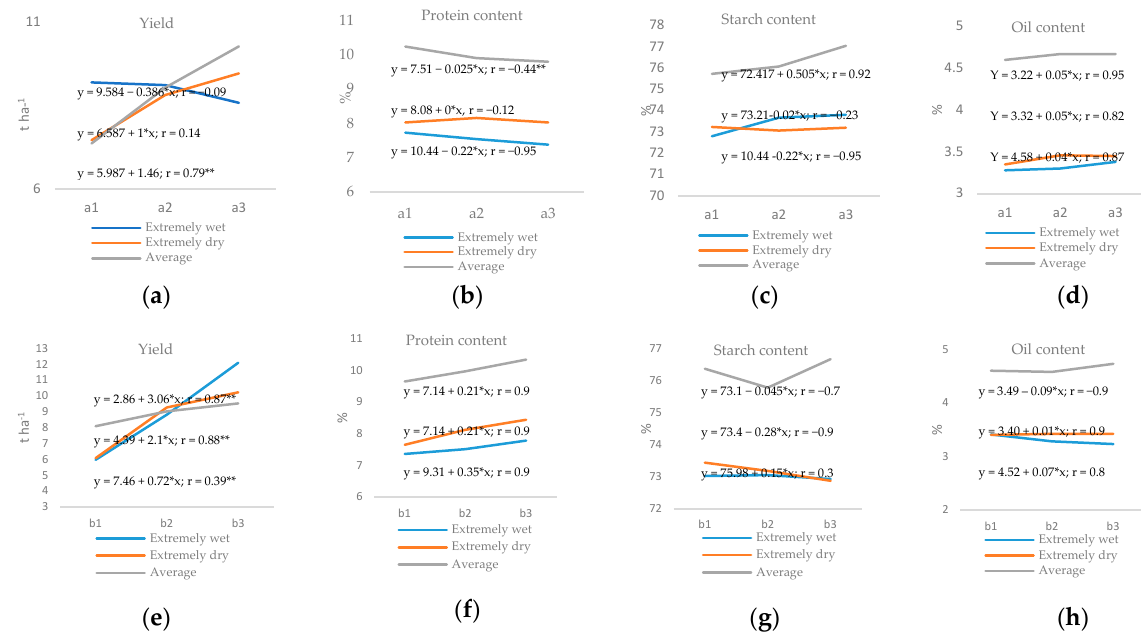
Figure 7. Relationship between irrigation (a1 = rainfed, a2 = 60–100% field capacity (FC), and a3 = 80–100% FC) and the tested variables—( a ) yield, ( b ) protein, ( c ) starch, and ( d ) oil content—and N fertilizer rate (b1 = 0 kg N ha − 1 , b2 = 100 kg N ha − 1 , b3 = 200 kg N ha − 1 ) and the tested variables—( e ) yield, ( f ) protein, ( g ) starch, and ( h ) oil content—in different weather conditions (extremely wet, extremely dry, and average year) significantly different at p < 0.05 (*) and p < 0.01 (**).